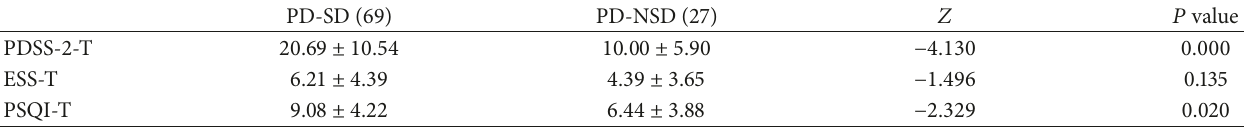
Table 1: Comparison of subjective sleep in PD-SD and PD-NSD.